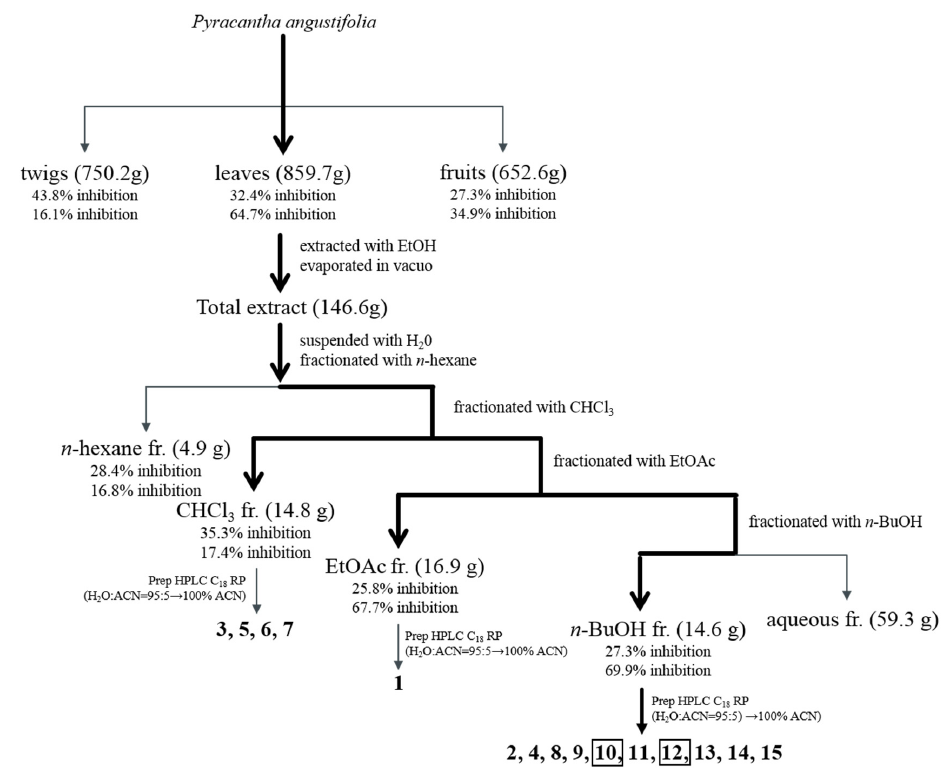
Figure 3. Schematic representation of the isolation of compounds 10 (HG) and 12 (CH) from PAL using bioactivity-guided fractionation. Bioactivity-guided fractionation of PAL was performed as shown in the schematic representation and resulted in the isolation and identification of compounds 10 and 12. Fractionation was guided by assessing the inhibitory e ff ect of HG and CH on melanin content without cytotoxicity and DPPH radical activity at 100 µ g / mL. At each level of fractionation, all the fractions generated were tested simultaneously and were compared to the crude extract.